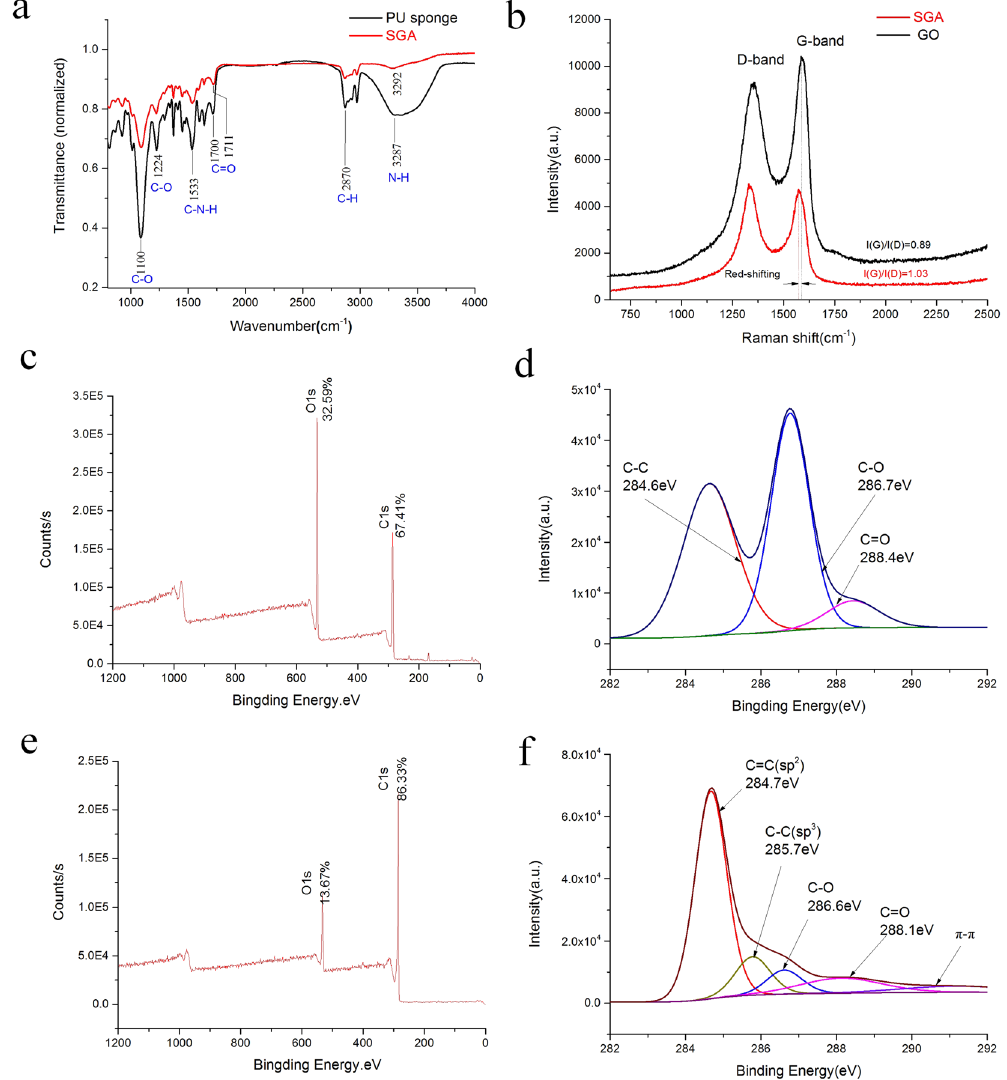
Figure 2. ( a ) FTIR spectra of PUS and SGA; ( b ) Raman spectra; ( c , e ) XPS survey scan of GO and SGA; ( d , f ) XPS spectra (C1s) of GO and